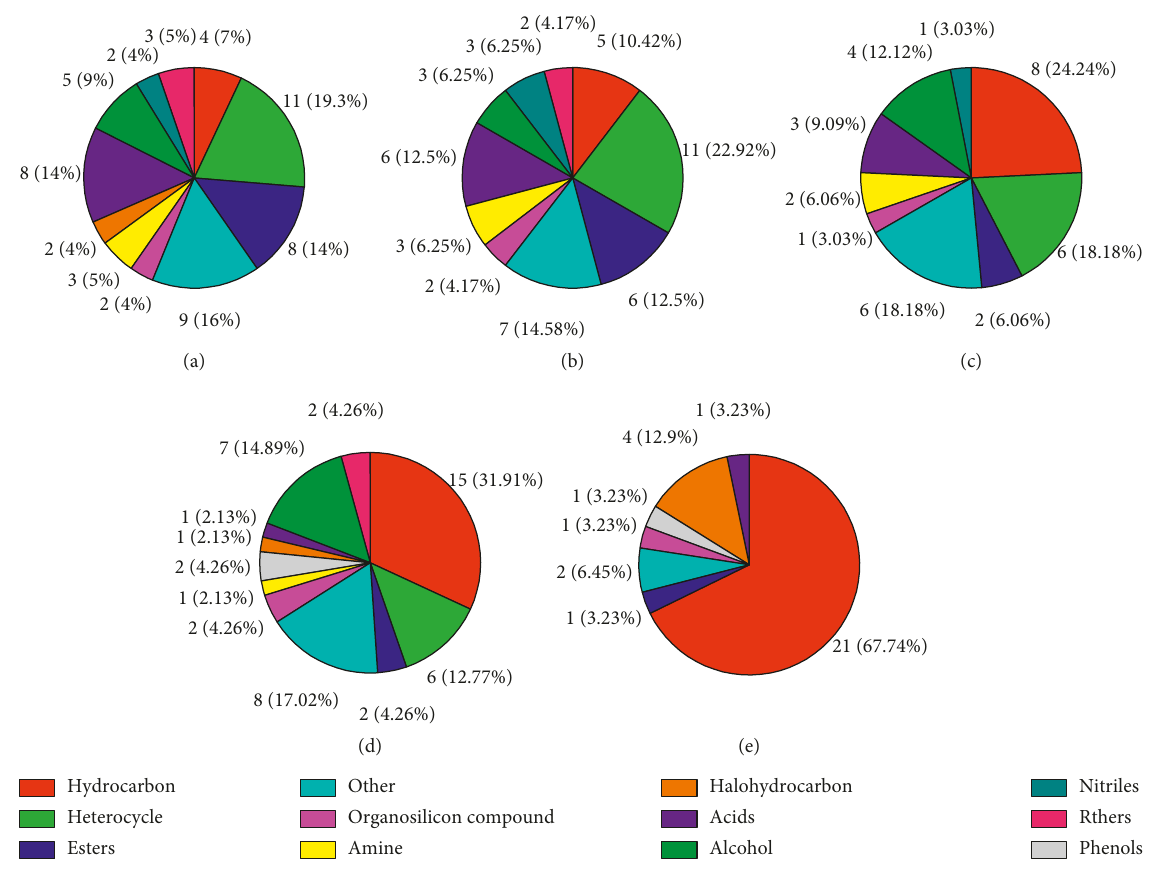
Figure 5: Distributions of organic compound classes during each stage of a typical traditional treatment process. (a) Raw water, (b) primary treatment, (c) anaerobic, (d) aerobic, (e)